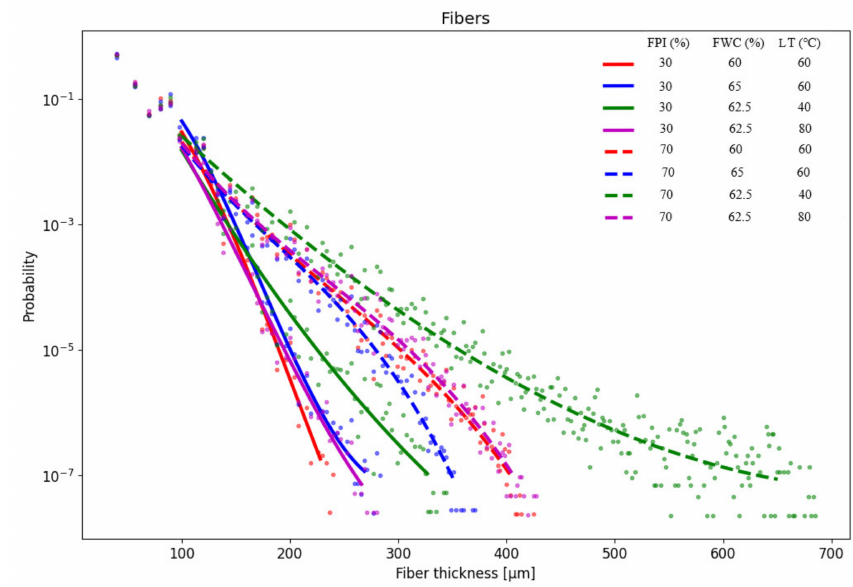
Figure 6. Results from the measurement of the fibre thickness of the meat analogues containing 30 and 70% FPI (faba bean protein isolate) at various feed water contents (FWC) and long cooling die temperatures (LT).